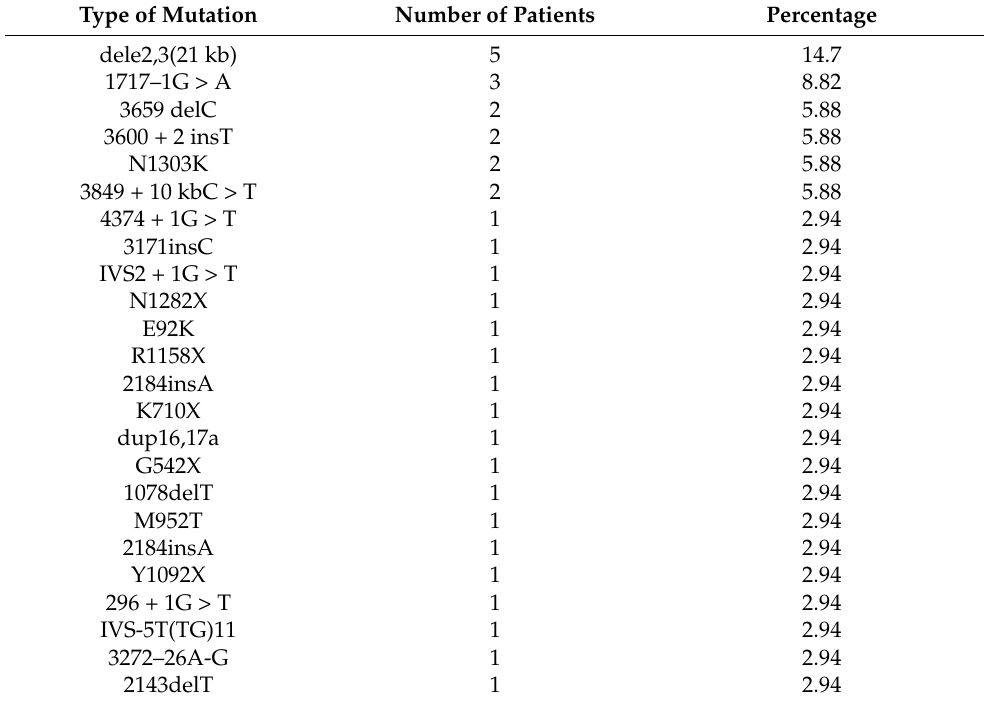
Table 1. Types of mutation detected in the heterozygous subgroup for deltaF508.